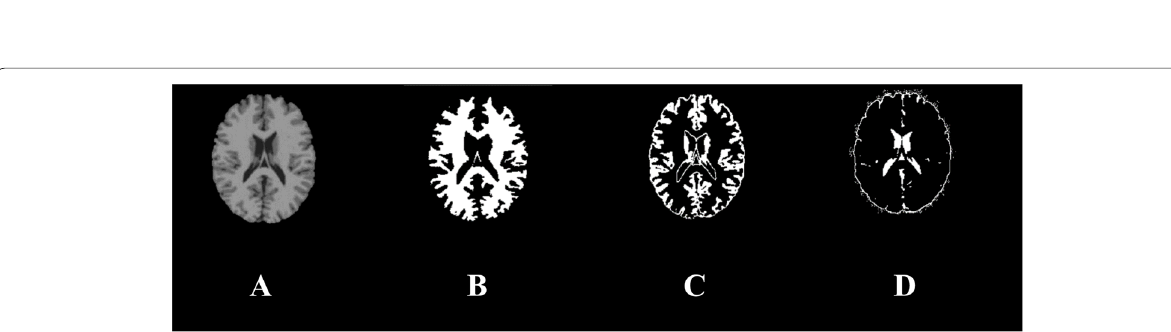
Fig. 3 Segmented images. A Original image. B White matter of the brain. C Gray matter of the brain. (The segmented image into white matter, gray matter, and cerebrospinal fluid)